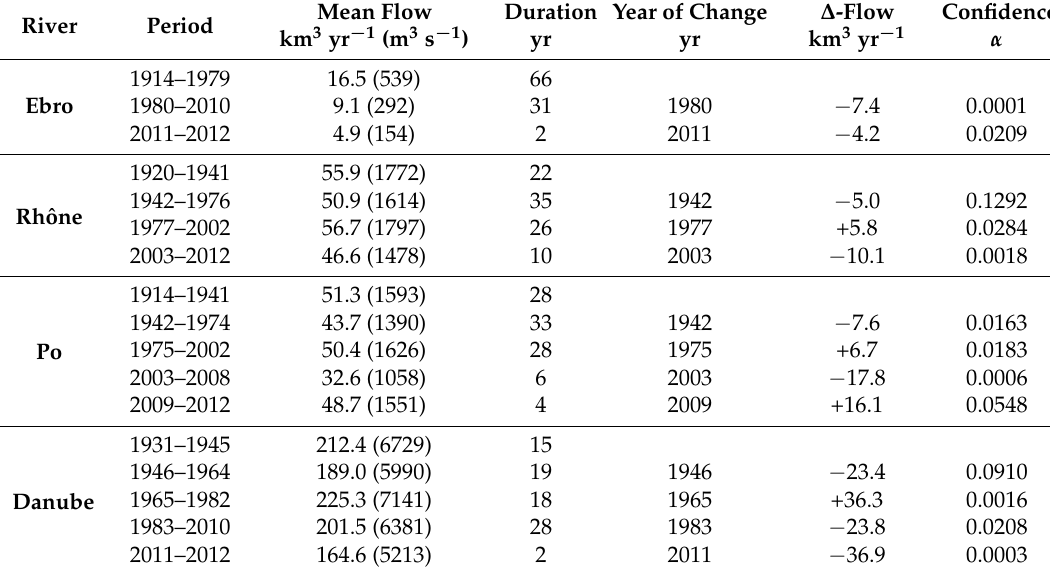
Table 2. Analysis of the discontinuities in the series of annual river water discharge by SRSD method (cut-off length = 10 yr, Huber’s weight = 1): periods of homogenous flow, year of the shift, change of annual flow ( ∆ -flow) and confidence level ( α